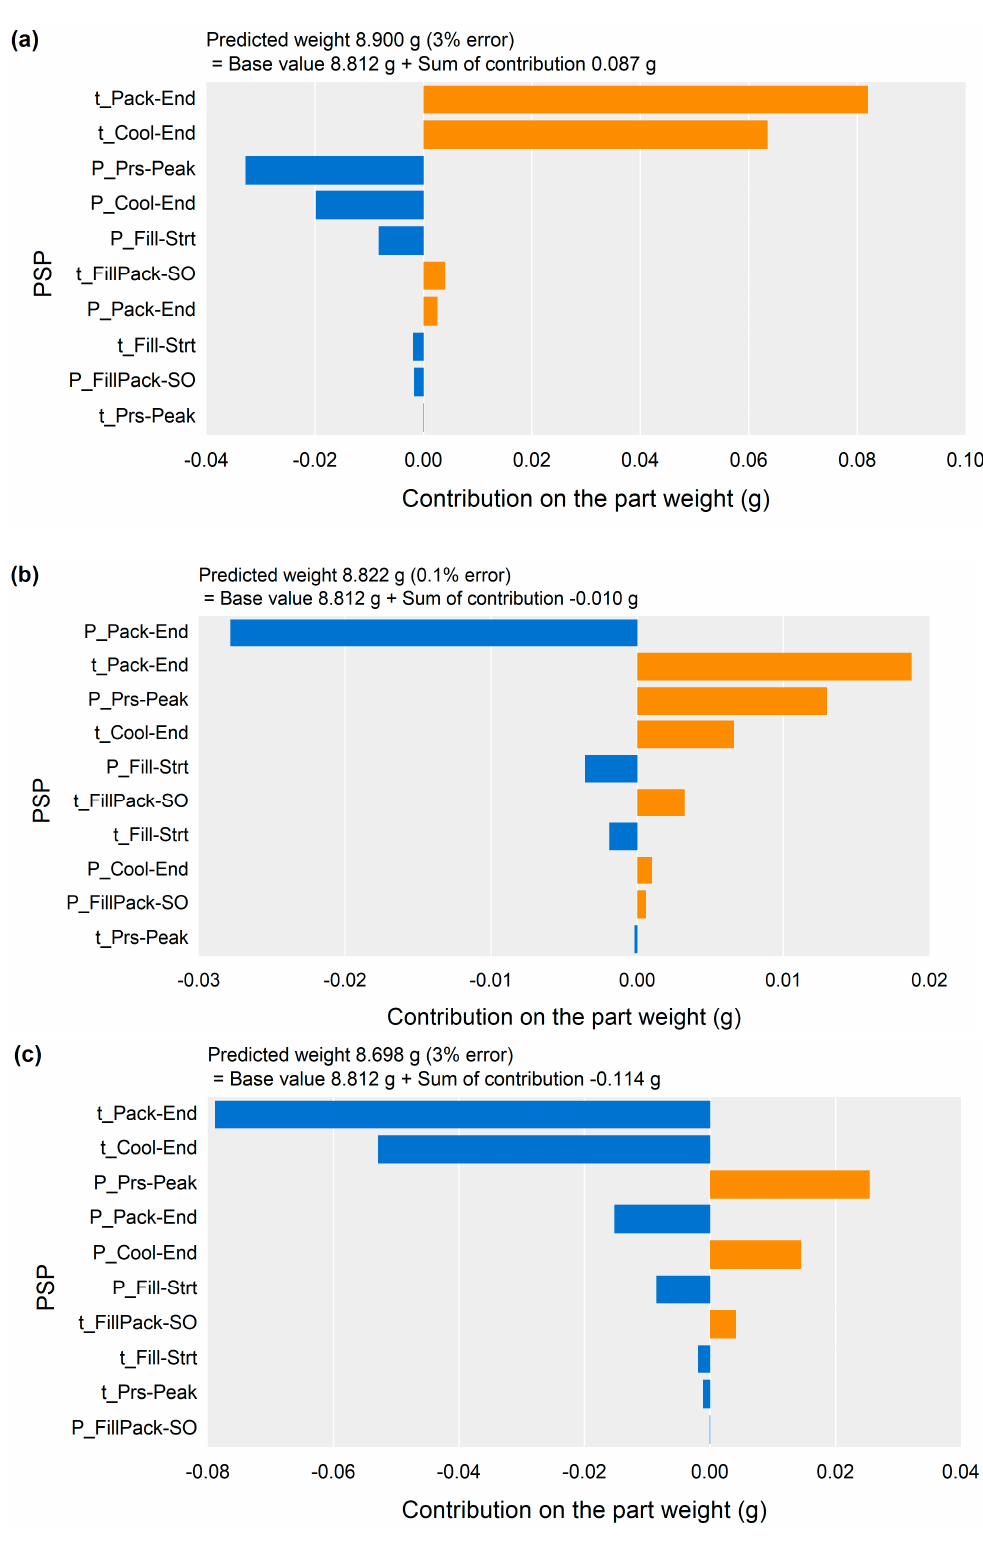
Figure 12. Contribution analysis results for the specific samples, ( a ) the highest-weight sample, ( b ) the middle-weight sample, and ( c ) the lowest-weight sample.